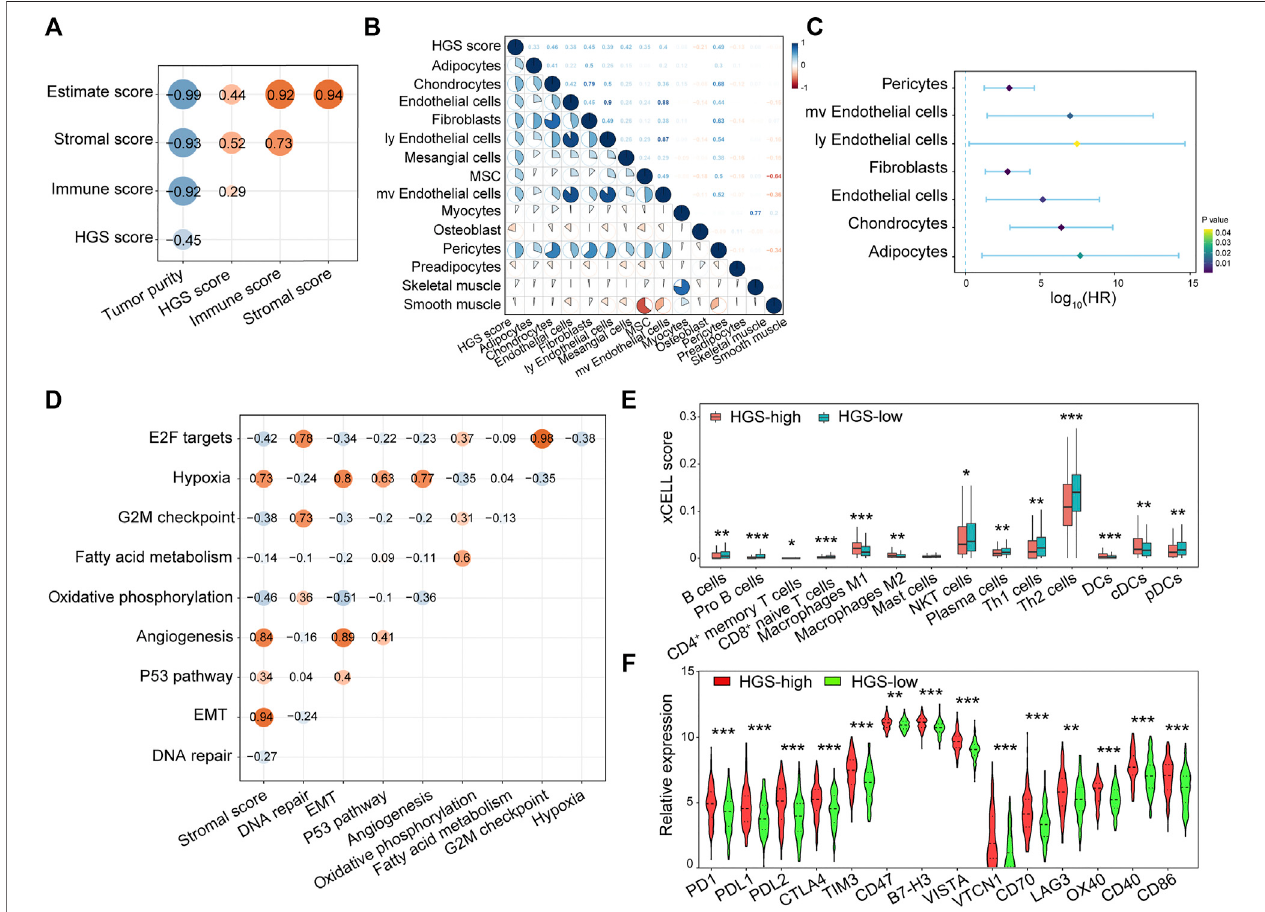
FIGURE 4 | The correlation between HGS and immune cells, stromal cells in fi ltration. (A) Spearman correlation analysis between HGS score and immune cells, stromal cells in fi ltration. (B) The correlation between HGS score and various stromal cells. (C) Forest plot of HR for various prognostic stromal cells. (D) The correlation between hypoxia and cancer hallmarks. (E) The in fi ltration level of14 immunecells. (F) The expression pattern of immune checkpoint-related and immune active genes.